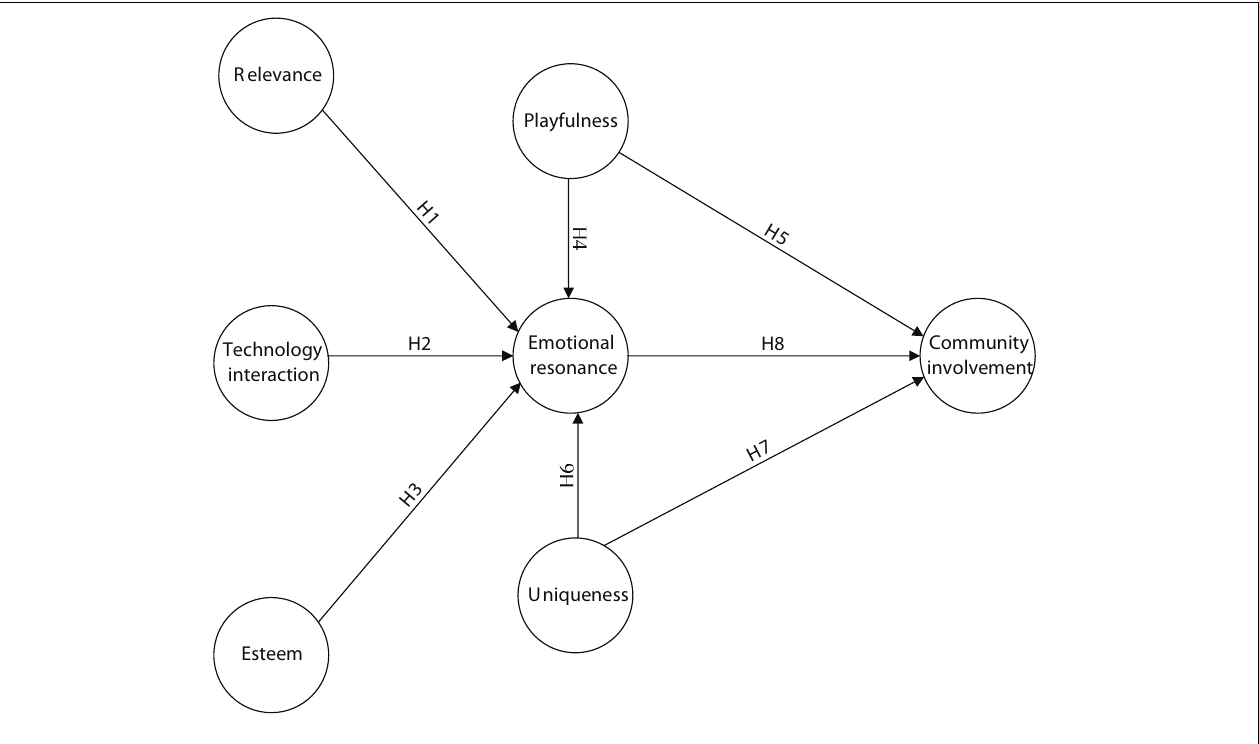
FIGURE 1 | The conceptualized structural research